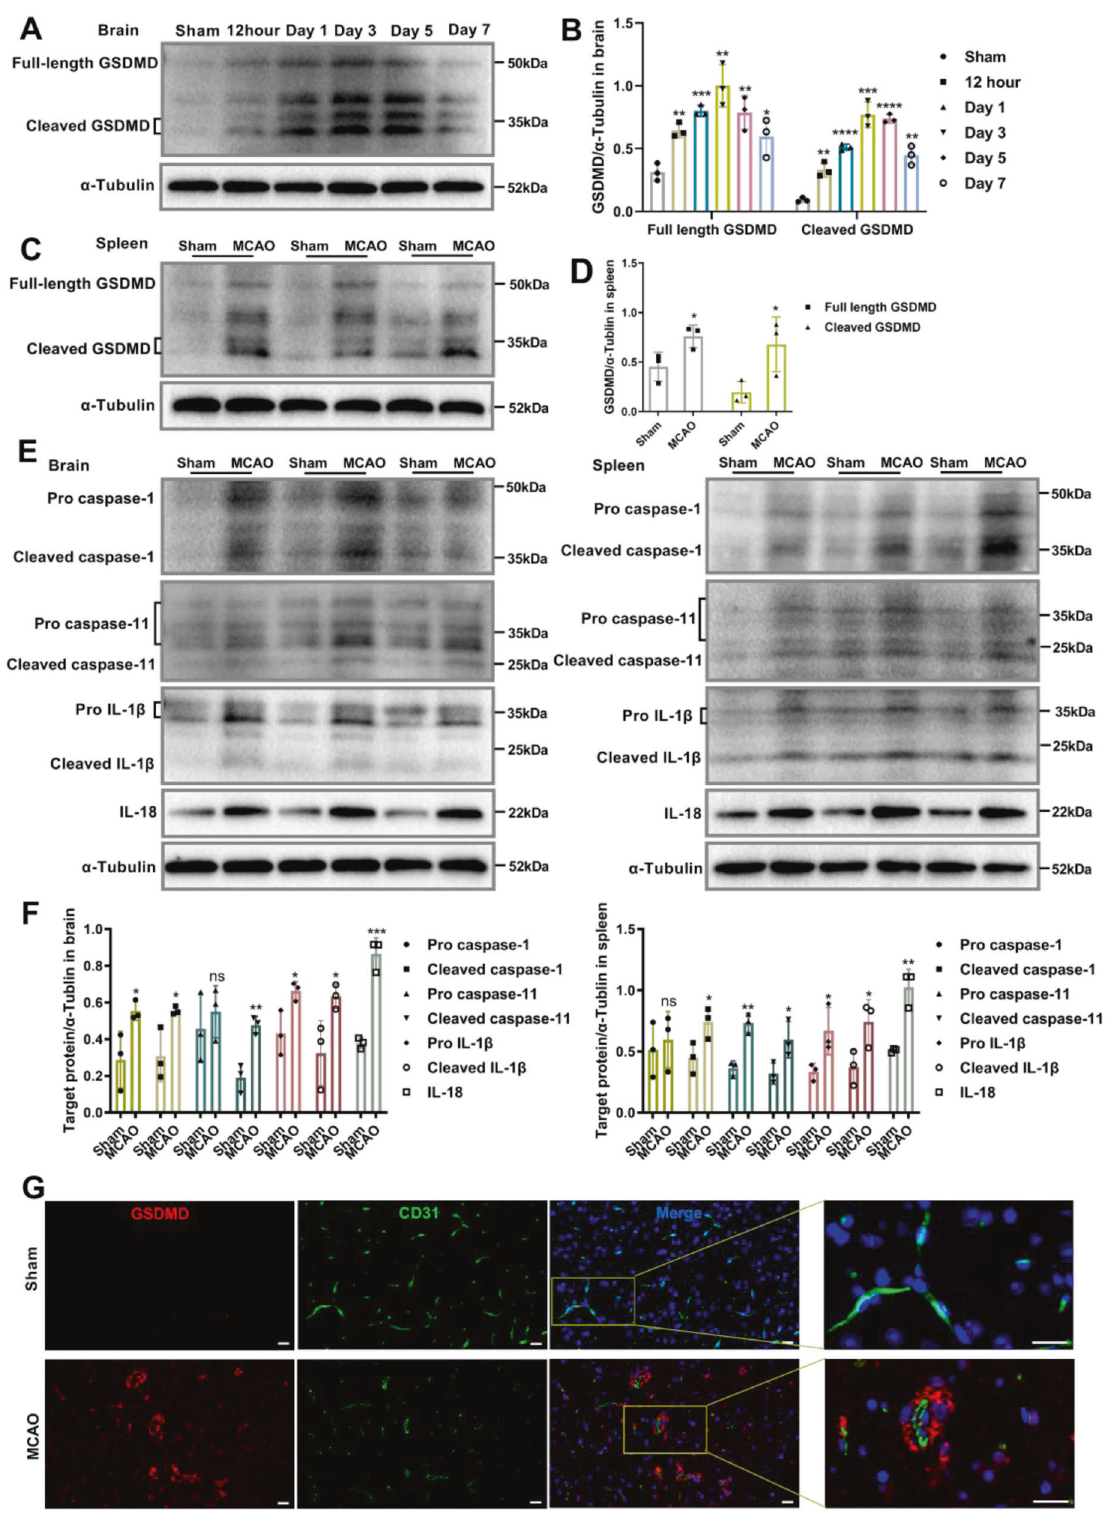
Fig. 1 GSDMD is activated in the early phase of ischemic stroke. A , B Representative immunoblots and quanti fi cation of the time course of GSDMD levels in brain of mice after MCAO compared with sham-operated mice ( n = 3). C , D Representative immunoblots and quanti fi cation of GSDMD levels in spleen of mice 3 days after MCAO compared with sham-operated mice ( n = 3). E , F Representative immunoblots and quanti fi cation of caspase-1/11 and IL-1 β /18 levels in the spleens and brains of mice 3 days after MCAO compared with sham-operated mice ( n = 3). G Representative images of double immuno fl uorescent staining for GSDMD and CD31. Arrowheads indicate perivascular GSDMD- positive cells. Scale bars, 20 μ m. The data are presented as the mean ± SD. Statistical analysis: One-way analysis of variance followed by Bonferroni ’ s multiple comparison test ( B ) or multiple two-tailed unpaired Student ’ s t test ( D and F ). ns not signi fi cant, * P < 0.05, ** P < 0.01, *** P < 0.001, **** P < 0.0001 vs sham-operated mice. Cell Death Discovery (2023)